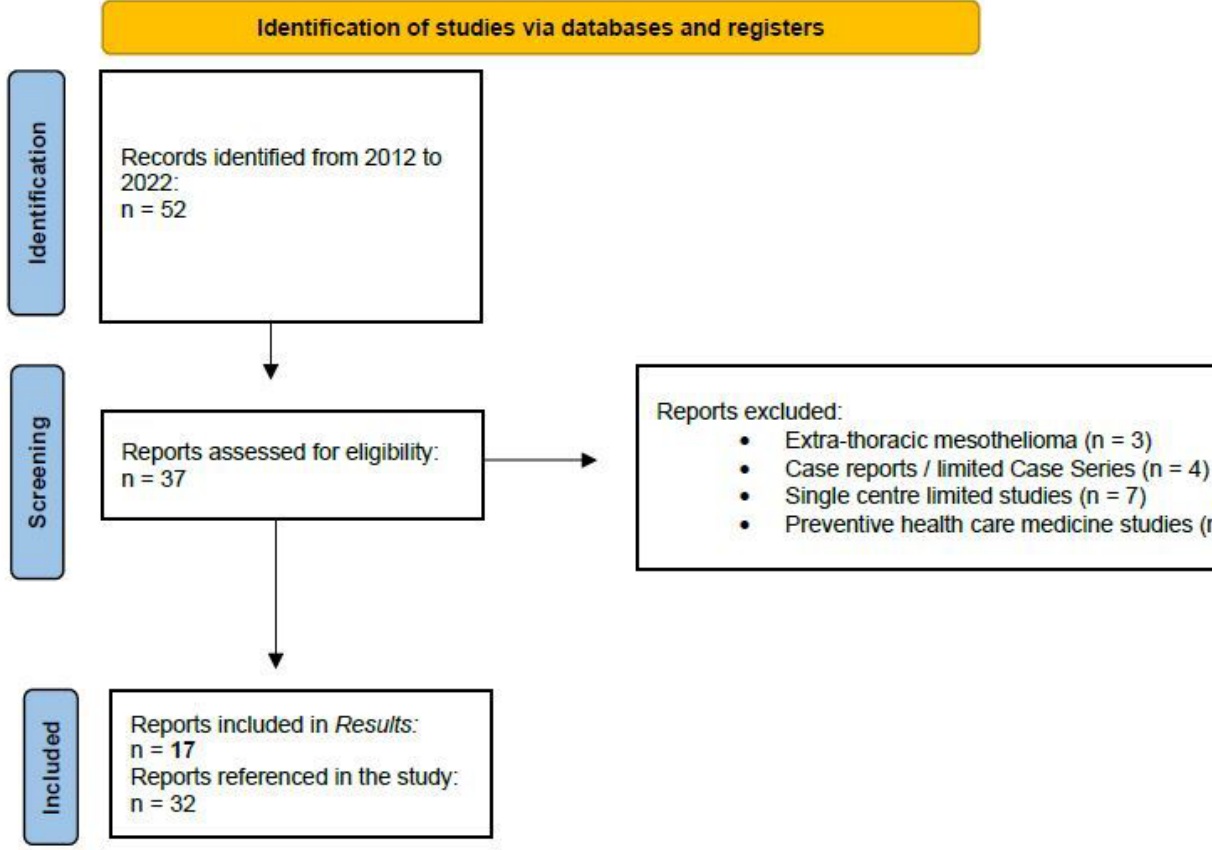
Figure 1. The flow diagram showing the criteria for the identification and selection of the studies included in this review. included in this